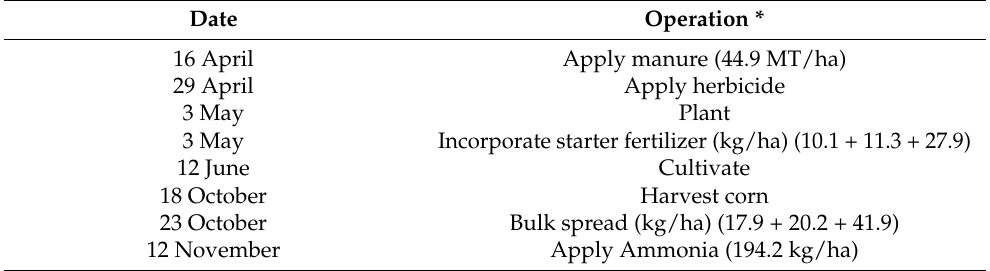
Table 1. Field operations simulated for no-till continuous corn for 1998–2000 production years.